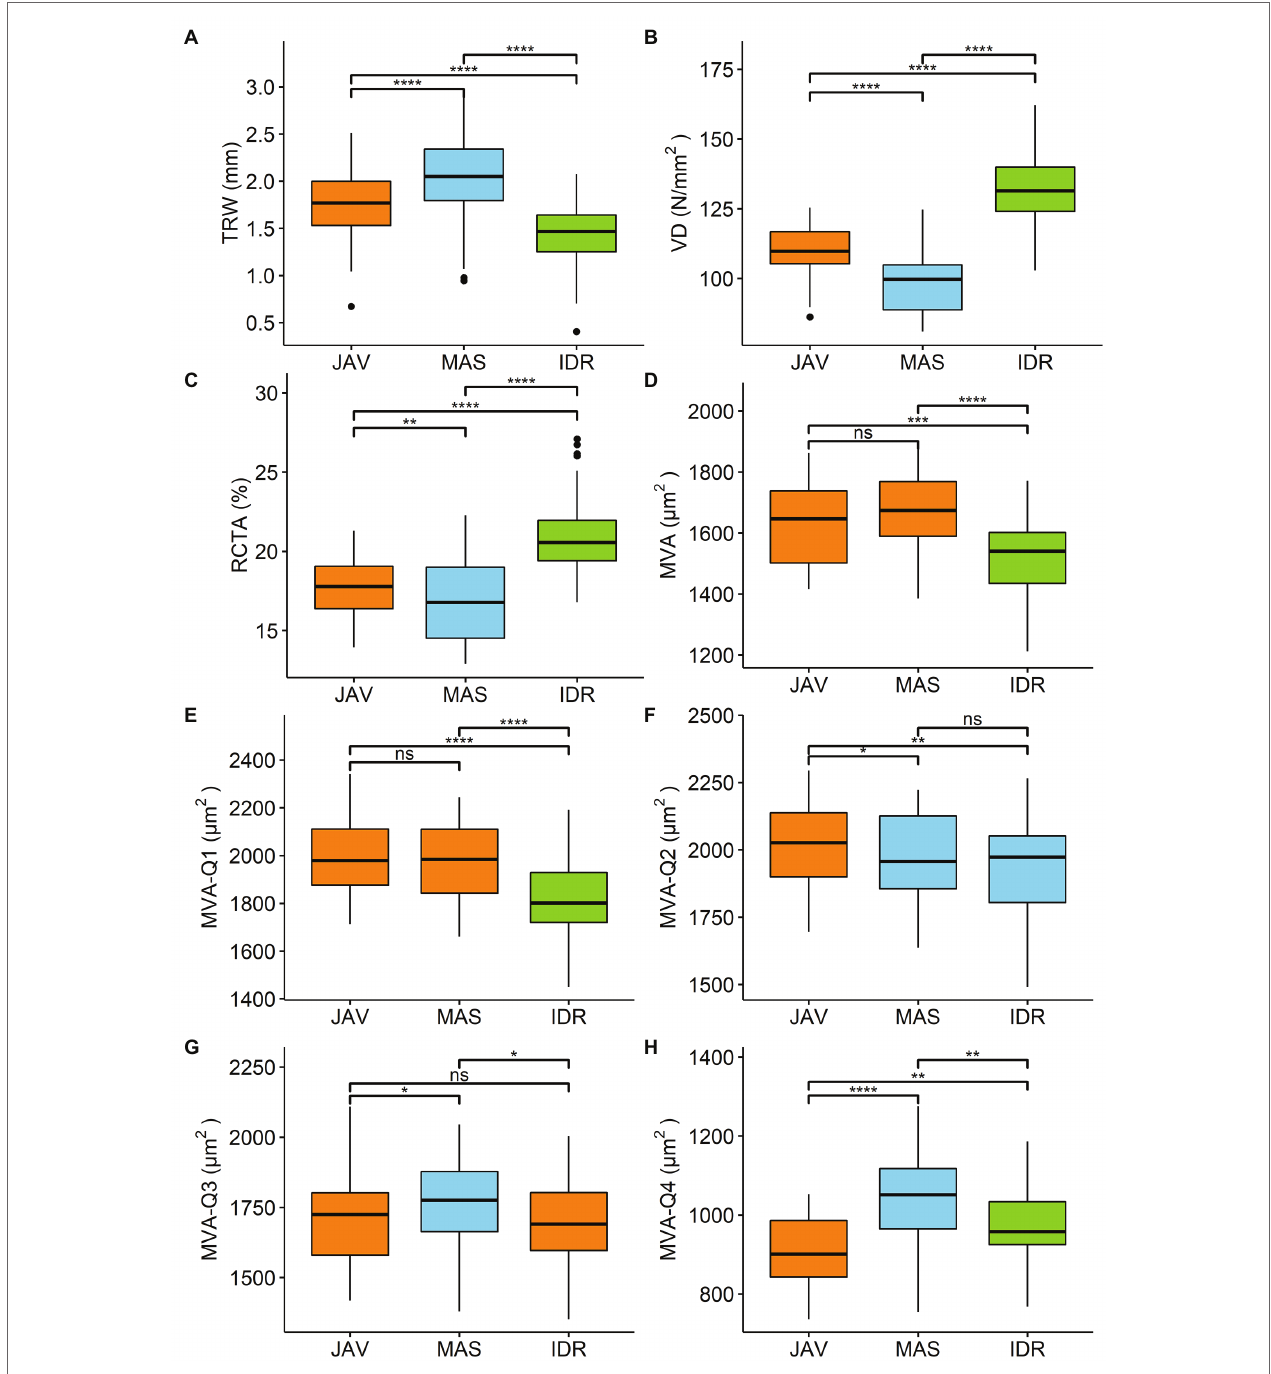
FIGURE 2 | Differences among the sites Javornik (JAV), Ma š un (MAS), and Idrija (IDR) in (A) tree ring width (TRW), (B) vessel density (VD), (C) relative conductive area (RCTA), (D) mean vessel area (MVA), and (E-H) MVA in first to fourth quarter of tree ring (MVA-Q1–MVA-Q4) analyzed by rm-ANOVA or the Friedman test. Significance of differences in tree ring characteristic between sites are market by ns-not significant. * p < 0.05, ** p < 0.01, *** p < 0.001, and **** p < 0.0001. Additional information is available in Supplementary Table S1